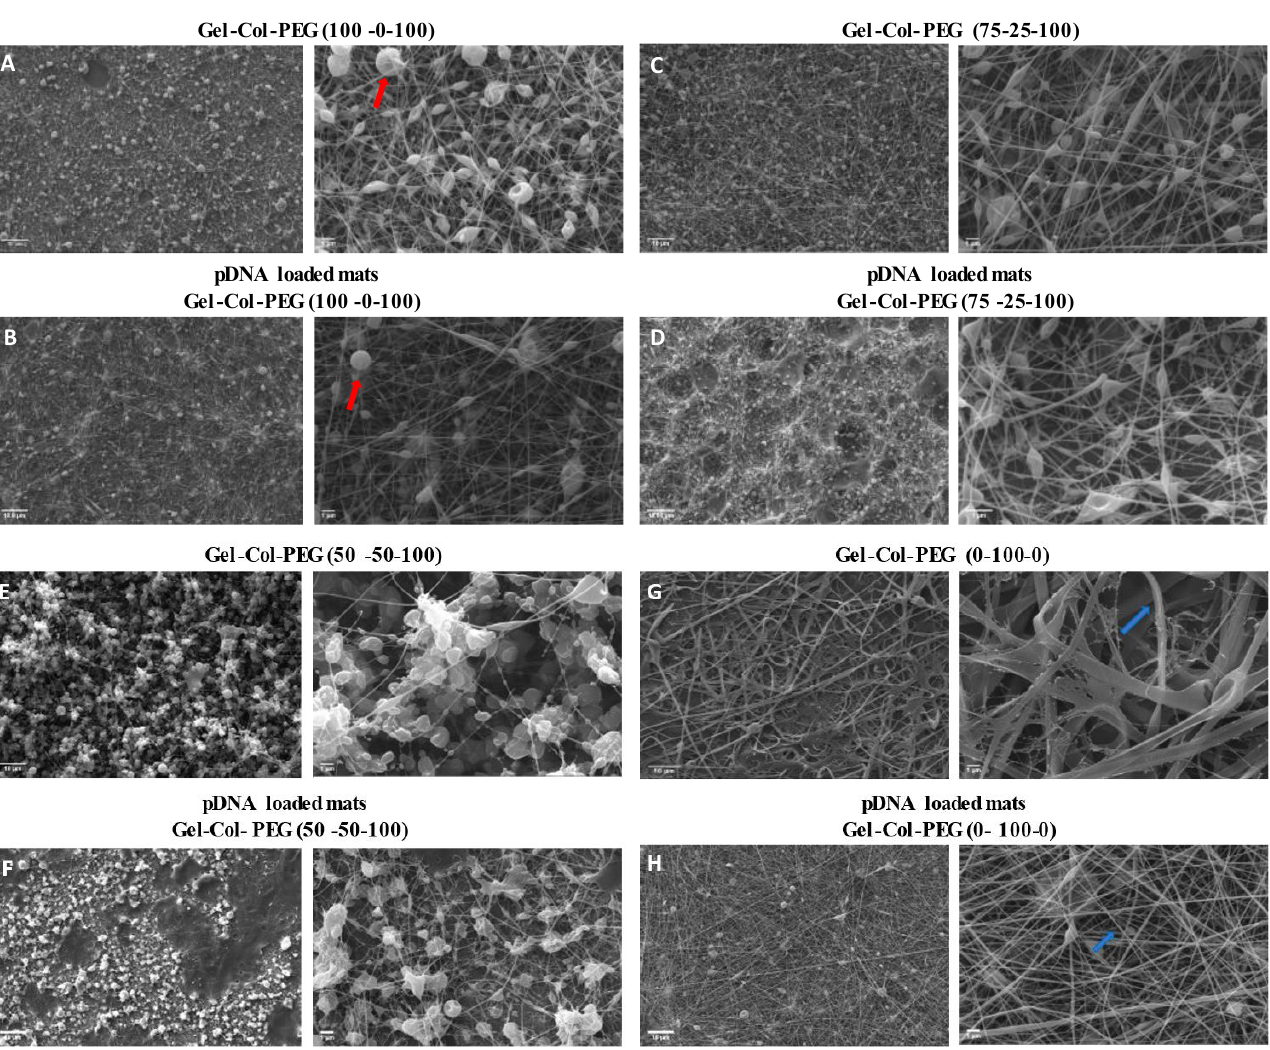
Figure 1. SEM images of different volume ratio Gelatin-Collagen-PEG electrospun fibers without and with complexes; Gelatine-Collagen-PEG (100-0-100) fiber mat without ( A ) and with pDNA complexes ( B ); Gelatine-Collagen-PEG (75-25-100) fiber mat without ( C ) and with pDNA complexes ( D ); Gelatine-Collagen-PEG (50-0-50) fiber mat without ( E ) and with pDNA complexes ( F ); Gelatine-Collagen-PEG (0-100-0) fiber mat without ( G ) and with pDNA complexes ( H ) (scale bars 10 and 1 µ m). Red arrows show some beads along the nanofibers (blue arrows).